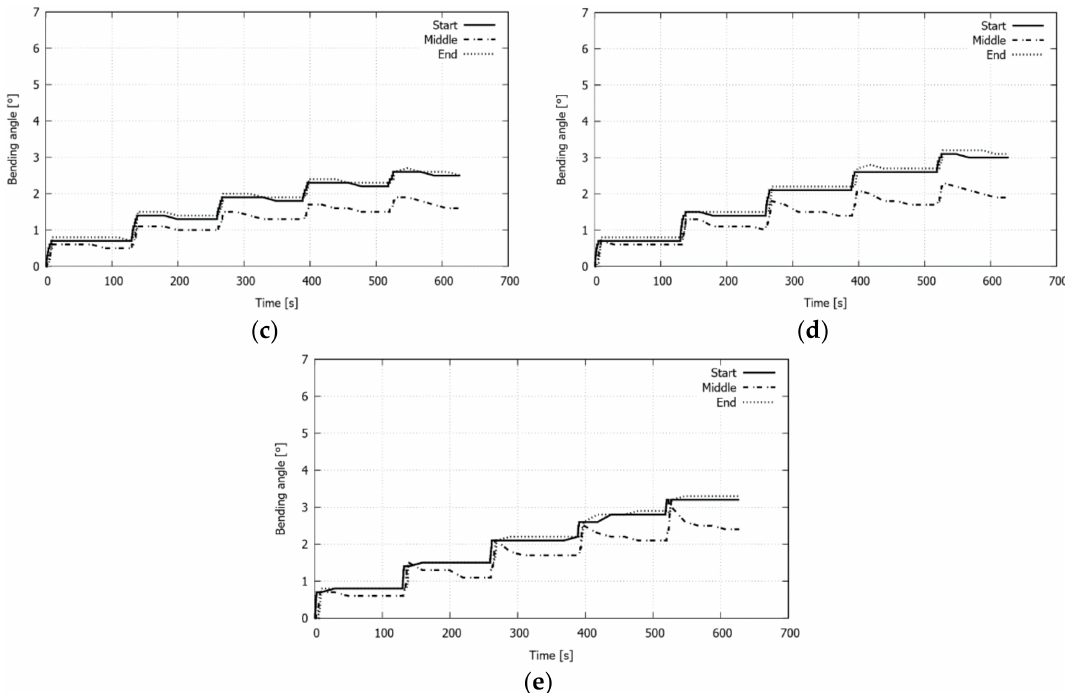
Figure 12. Multiple circular scanning path: computed bending angle evolution at three points of the free edge of the plate (except in a ), for which only the center point of the edge is considered) for the studied configurations, ( a ) r inn = 0 mm, ( b ) r inn = 10 mm, ( c ) r inn = 15 mm, ( d ) r inn = 20 mm, and ( e ) r inn = 25